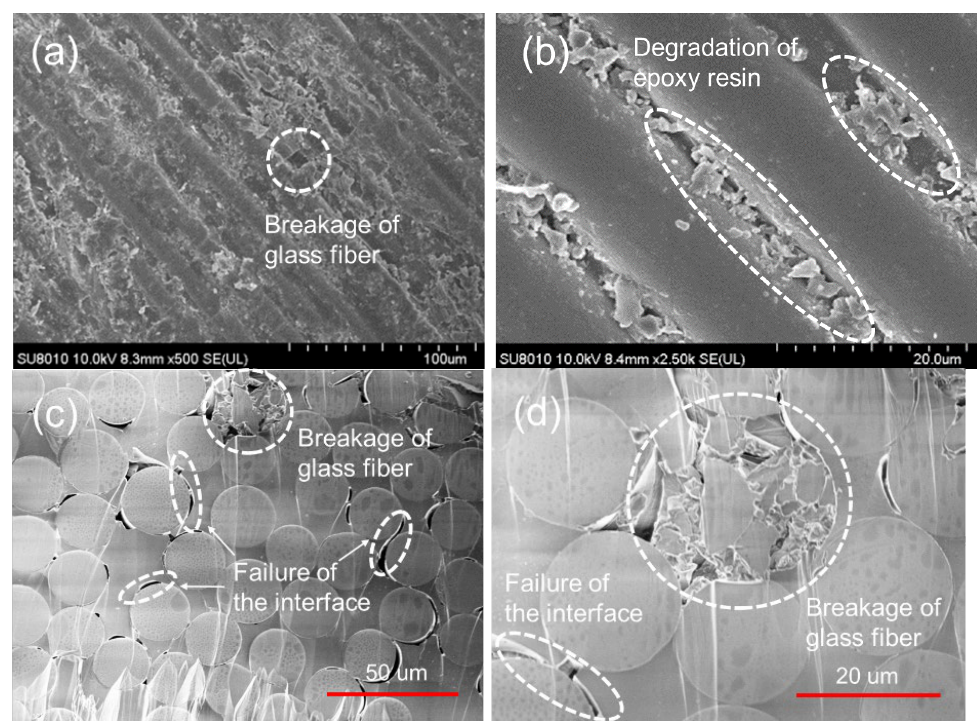
Figure 7. The micro morphology of the Type II sample after 480 h in the deionized water. ( a ) side view, magnified 500 times; ( b ) side view, magnified 2500 times; ( c ) cross section view, magnified 500 times; ( d ) cross section view, magnified 2500 times.